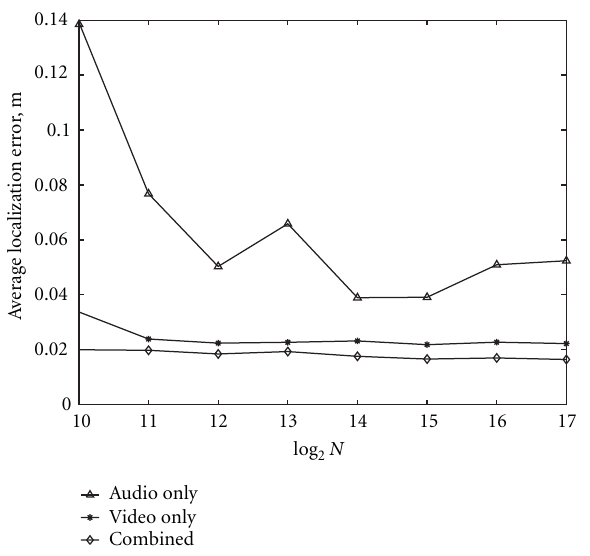
Figure 2: Unimodal and multimodal tracking performance. All parameters of the system are taken from the real setup.